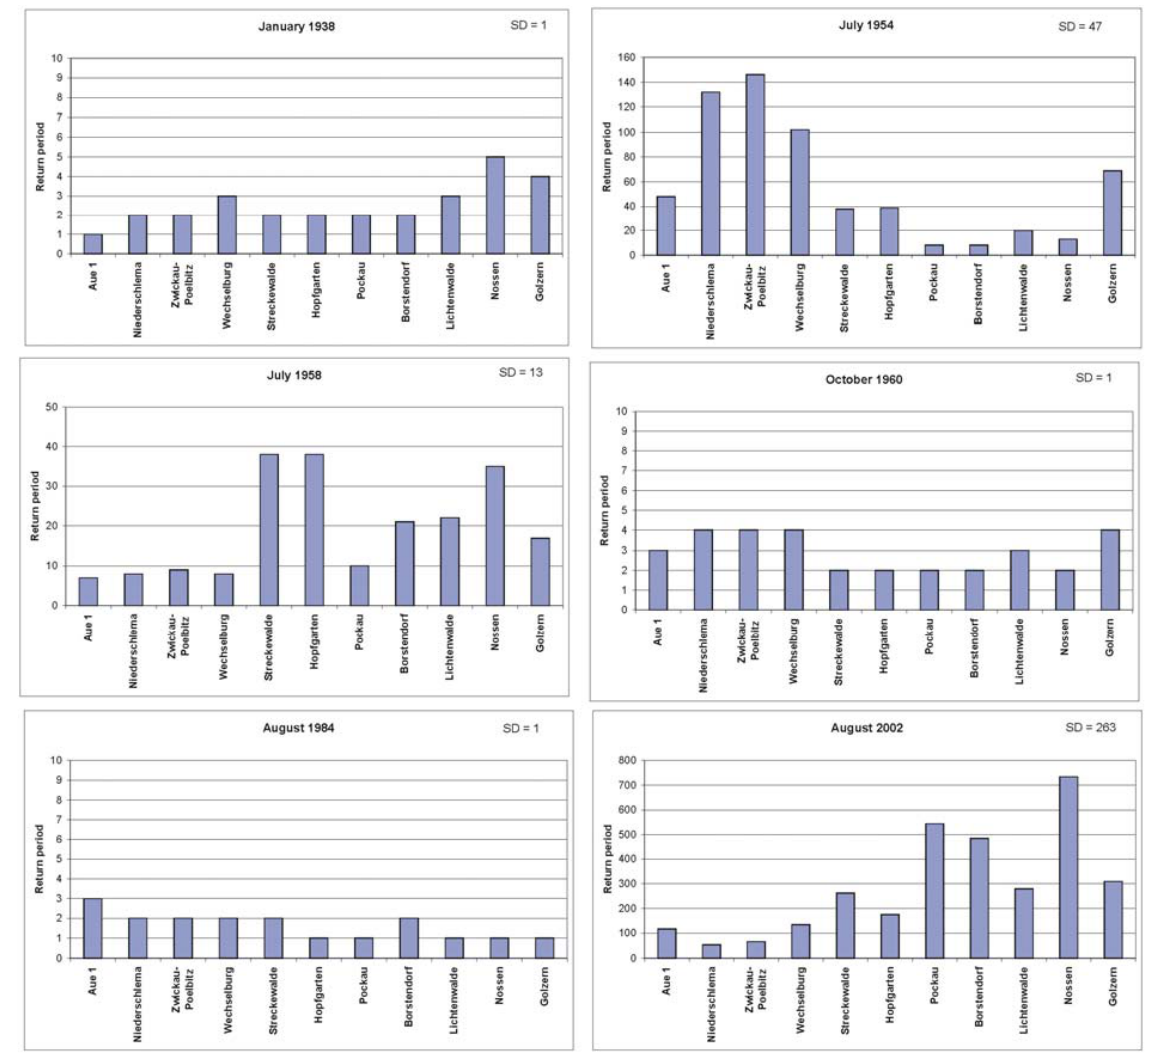
Figure 5: Variation of return periods for six different floods (SD = standard deviation) Fig. 5. Variation of return periods for six different floods (SD = standard